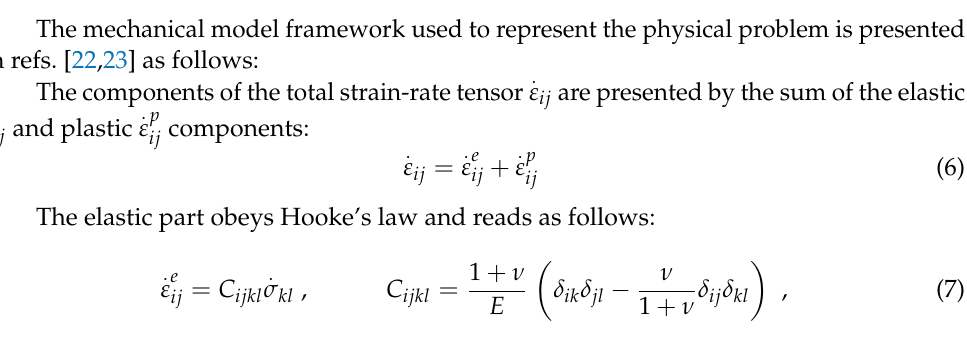
Figure 2. Temperature-dependent material properties for AISI 310 austenitic steel: ( a ) density; ( b ) specific heat; ( c ) thermal conductivity; ( d ) Young’s modulus; and ( e ) yield strength.